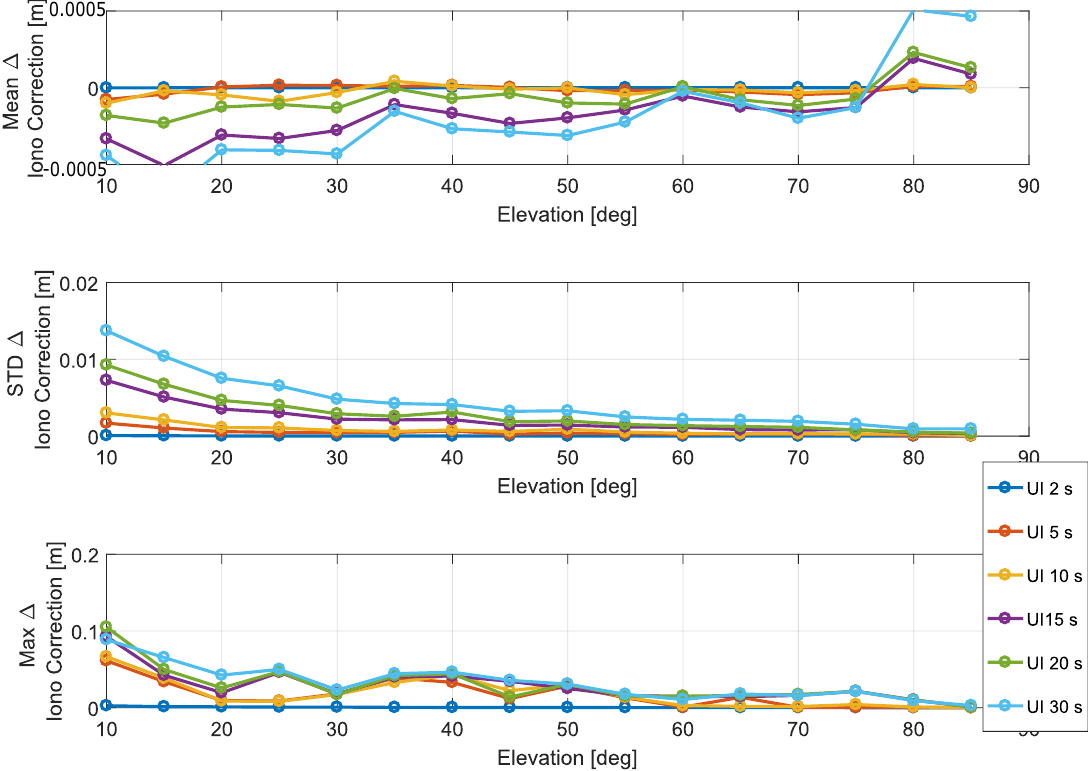
Figure 6. Statistical parameters of the ionospheric correction differences as a function of the elevation angle. In the legend, “UI” stands for “Update